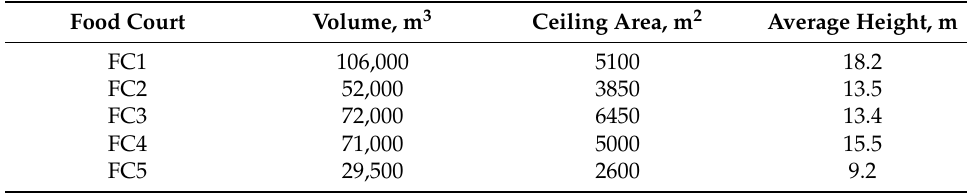
Figure 1. Floor plans and sections of the studied food courts. Red lines show the ceiling contour if it does not coincide with the floor contour. Table 1. Geometrical characteristics of the food courts.